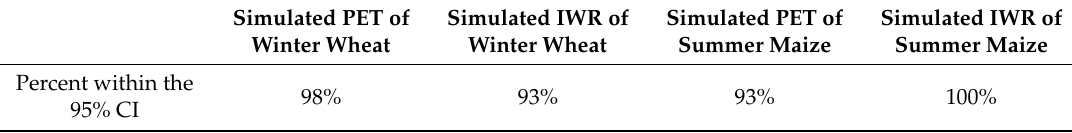
Table 12. Percent of simulated PET and IWR within the 95% CI for winter wheat and summer maize. Simulated PET of